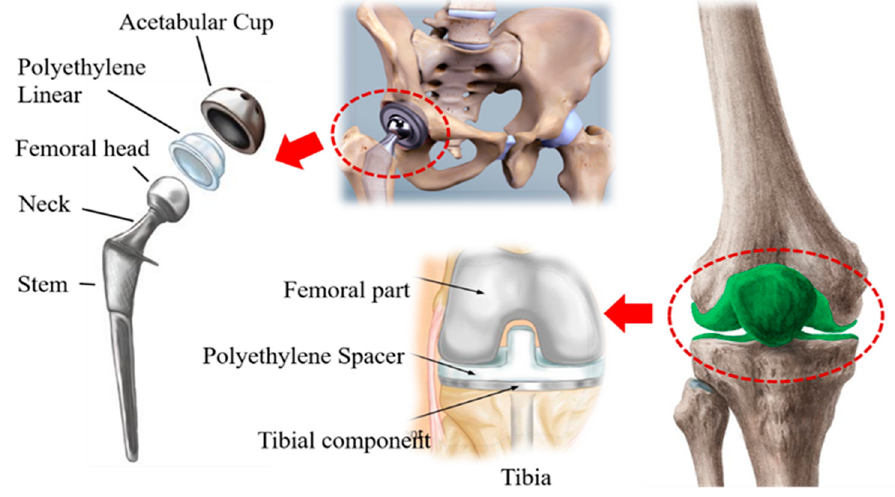
Figure 1. Schematic diagram showing Total Hip Replacement (THR) and Total Knee Replacement (TKR) [29].